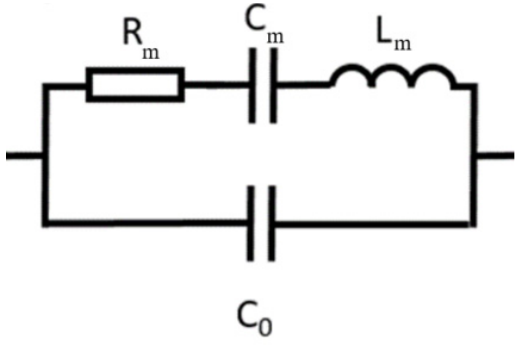
Figure 3. The Butterworth Van − Dyke equivalent circuit model.